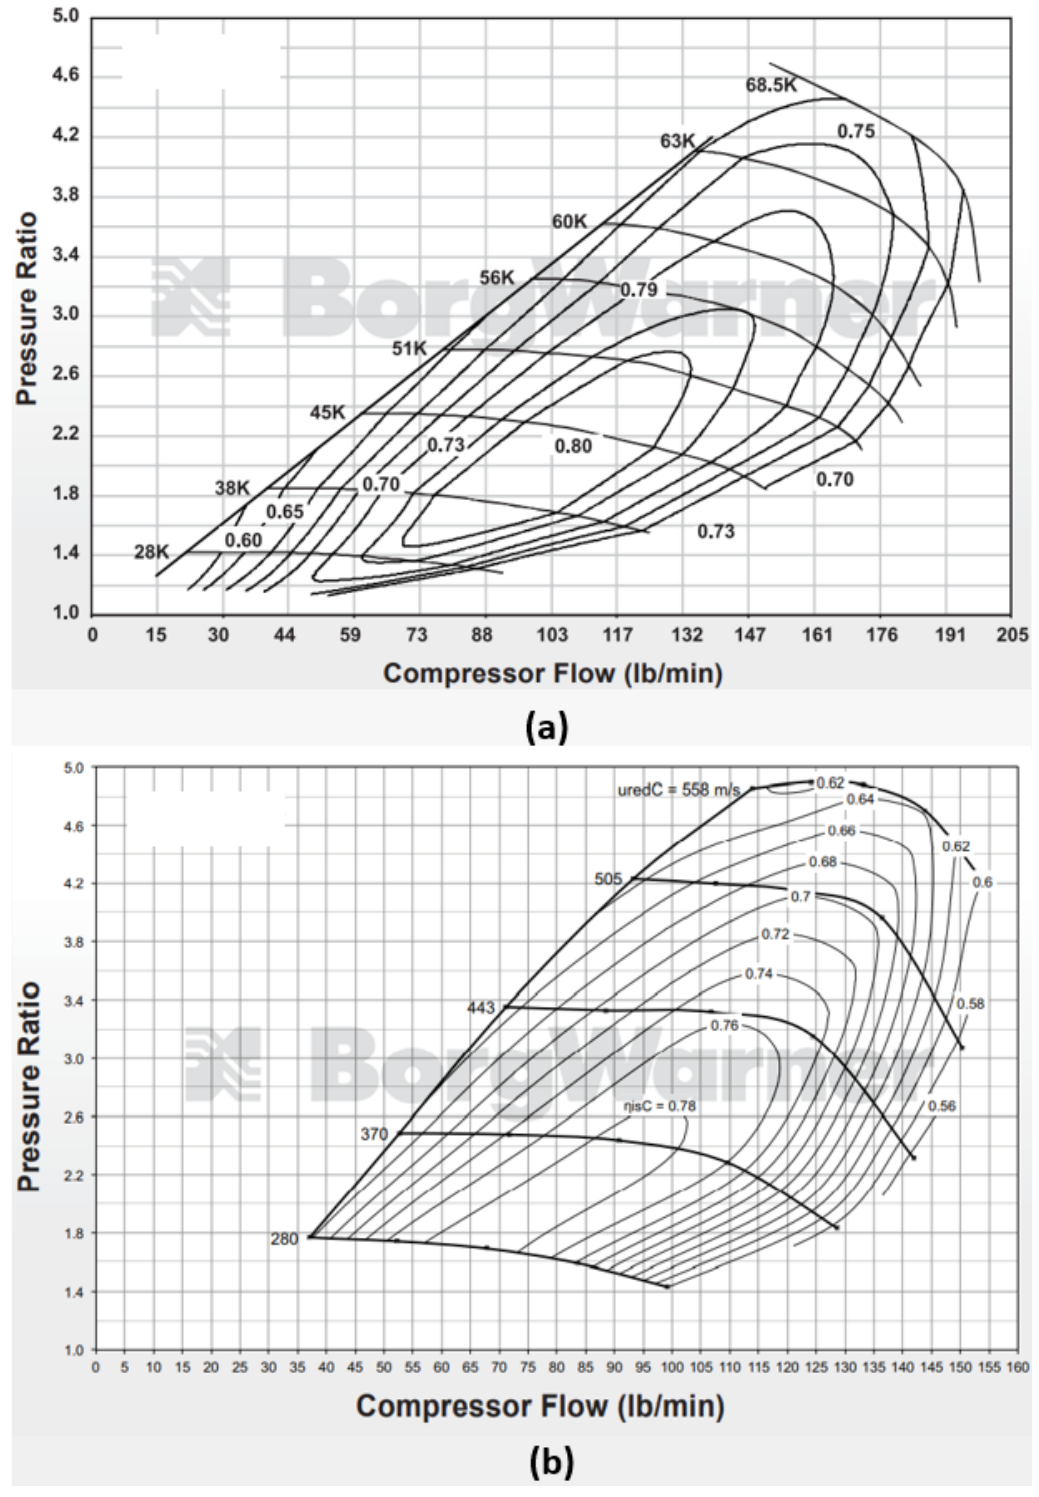
Figure 2. The performance data of ( a ) rotor A and ( b ) rotor B [24].